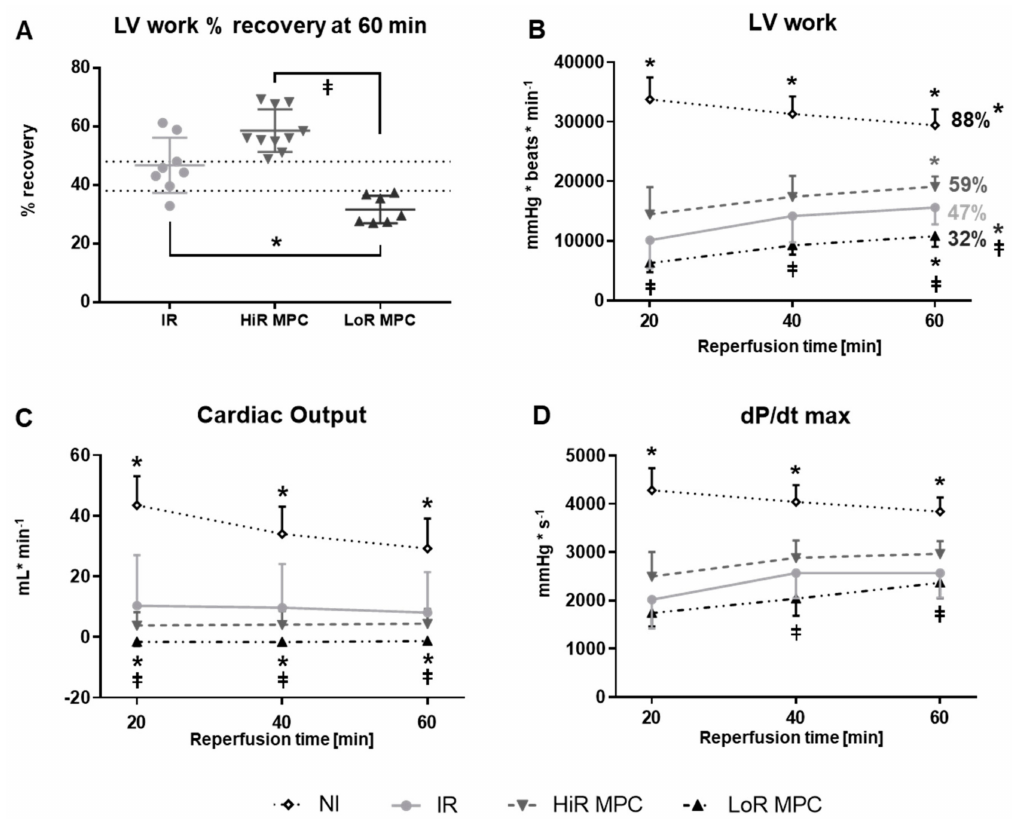
Figure 1. Post-ischemic contractile recovery. ( A ) Distribution of left-ventricular work (LV work = developed pressure × heart rate [mmHg × beats × min − 1 ]) recovery (LV work value at 60 min reperfusion expressed as a percentage of mean baseline value). Two MPC subgroups were observed: high (HiR) and low (LoR) recovery; ( B ) LV work (percentages: LV work values at 60 min reperfusion expressed as a percentage of mean baseline value); ( C ) Cardiac output; ( D ) dP / dt max